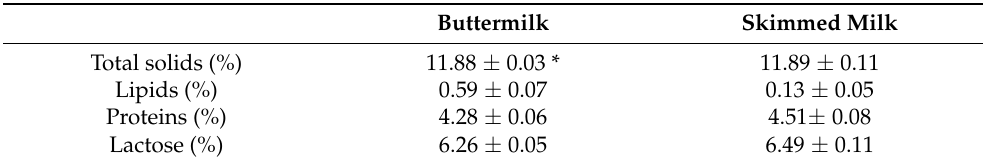
Table 1. Composition of the standardized buttermilk (BM) and skimmed milk (SM) mix used for yogurt